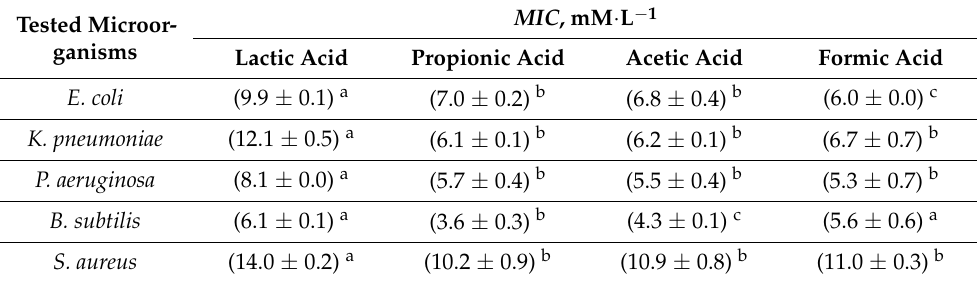
Table 5. The minimum inhibitory concentrations ( MIC ) of organic acids against the tested pathogens. MIC , mM · L − 1 Tested Microor- ganisms Lactic Acid Propionic